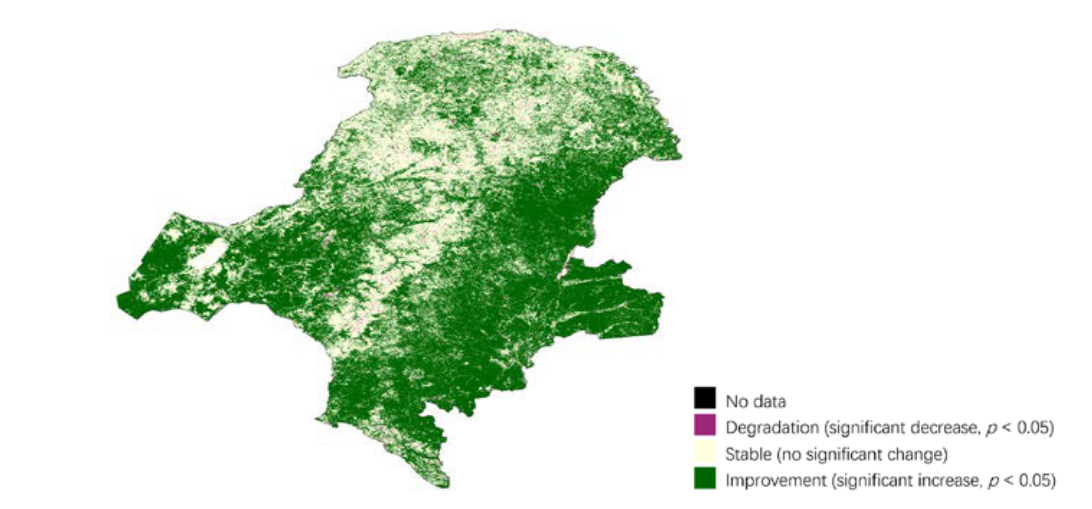
Figure 7. Productivity trajectory degradation in Great Khingan Mountain (GKM), China (2000–2018). Productivity state change can be reported in terms of three classes relative to the base- line productivity state: (1) Improvement: observed productivity in baseline iNDVI classes 9 or 10. (2) Stable: observed productivity in baseline iNDVI classes 6, 7 or 8. (3) Degradation: observed productivity in baseline iNDVI classes 1, 2, 3, 4 or 5. The forest experienced a degradation between the two periods, whereas the other land showed an improvement (Figure 8). The degradation areas, especially in forest area, consisted of productivity trajec- tory degradation. Figure 9 showed that most of the land use types had no degradation, except 0.6% grassland and cropland located in the eastern and southeastern areas.